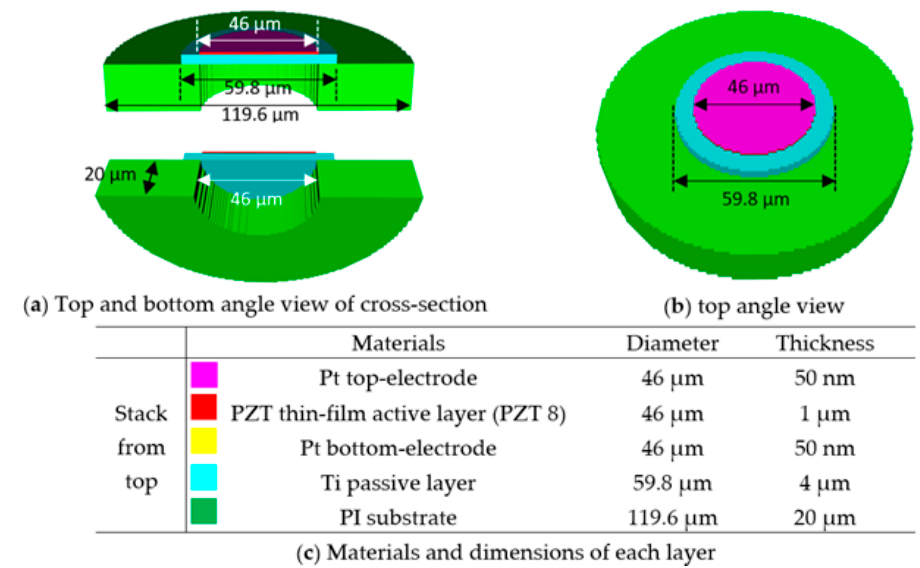
Figure 2. 10 MHz circular unit-cell prototype in ( a ) top and bottom cross-section, ( b ) top angle view and ( c ) materials and dimensions of each layer.